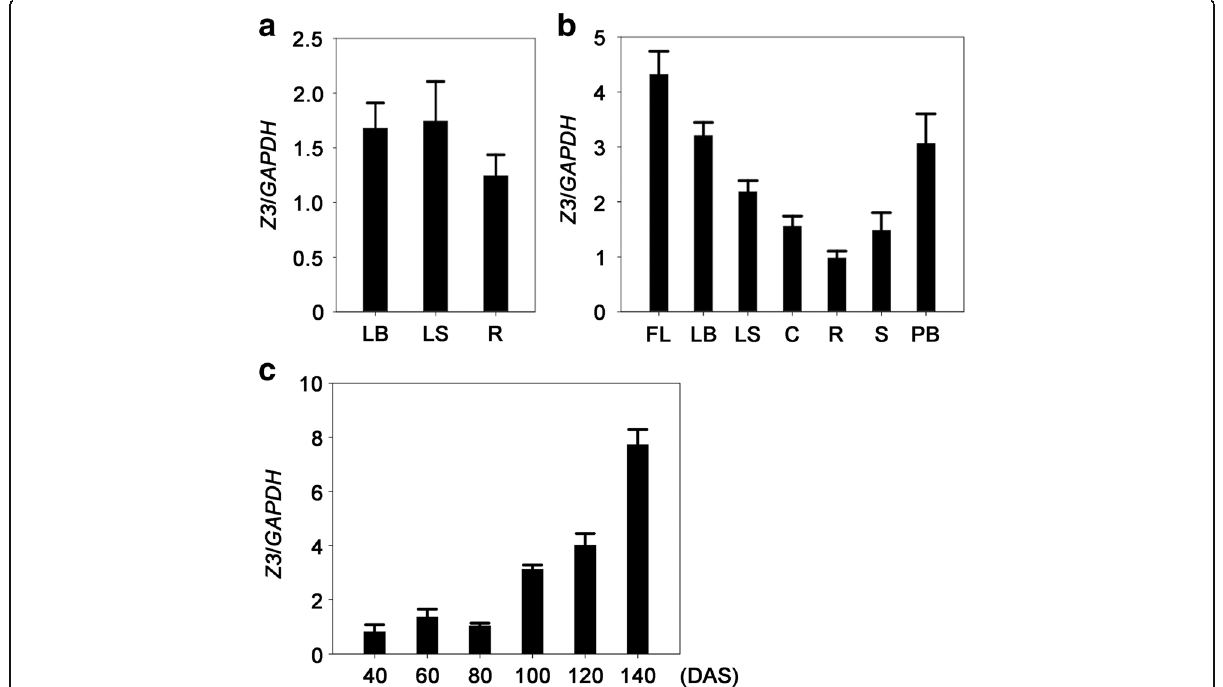
Fig. 6 Spatial and temporal expression of the Z3 gene. a Expression of the Z3 gene in different organs at the seedling stage. Different organs were sampled from 2-week-old seedlings (cv Kinmaze) grown under long-day conditions (14.5 h-light/9.5 h-dark) in the growth chamber. LB, leaf blade; LS, leaf sheath; R, root. b Spatial expression of the Z3 gene in different rice tissues at heading stage. Different tissues were sampled from the 115-day-old wild type grown under natural long-day conditions in the paddy field. FL, flag leaf; LB, leaf blade of the second leaf; LS, leaf sheath; C, culm; R, root; S, spikelet; PB, panicle branch. c Temporal expression of the Z3 gene. Samples were harvested from fully expanded young leaves of the wild type at different stages grown under natural long -day conditions. DAS, days after sowing. GAPDH was used as internal control. All data in Fig. 6 are means ± SD ( n =